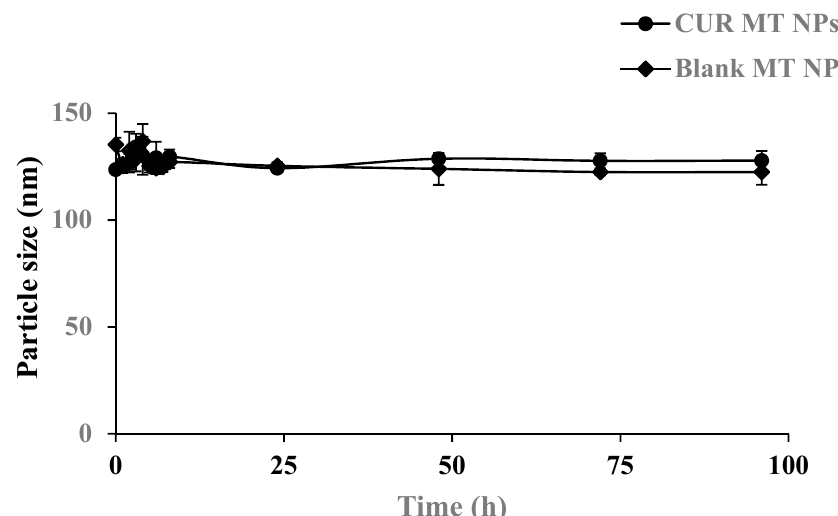
Figure 3. Physical stability of CUR MT NPs in a simulated physiological condition. The study was performed in PBS (pH 7.4) at 37 °C for up to 96 h. Blank MT NPs were used as a comparison. After equilibrating to room temperature, particle size was measured by dynamic light scattering. For all tested samples, P.I. < 0.25. Data are presented as the mean ± SD ( n =3). There was no significant difference in particle size over 96 h within the group or between the groups ( p > 0.05).